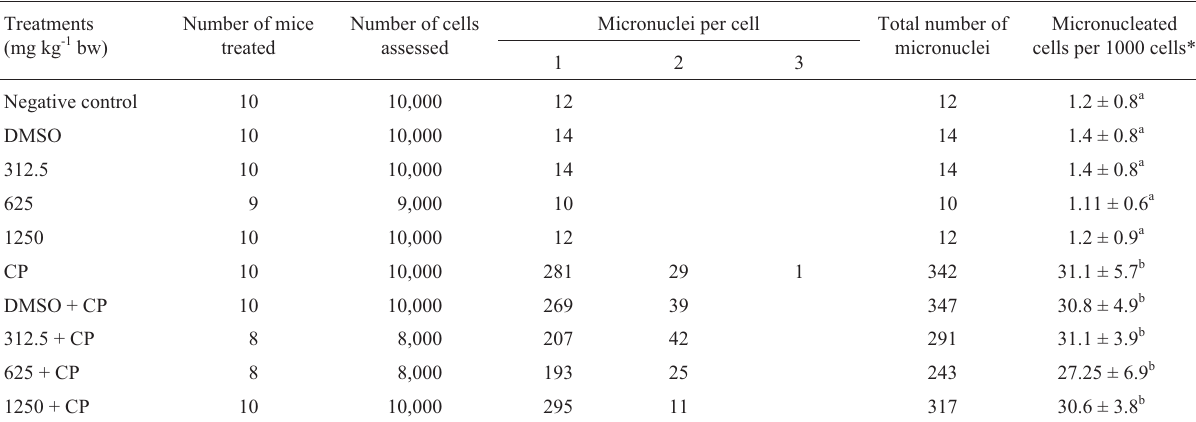
Table 1 - Micronucleus per cell, micronucleus total number and micronucleated cells frequency for a thousand polynucleated erythrocytes (PCEs) after the sub-chronic treatment with methanol extract of Croton cajucara Benth. Treatments (mg kg -1